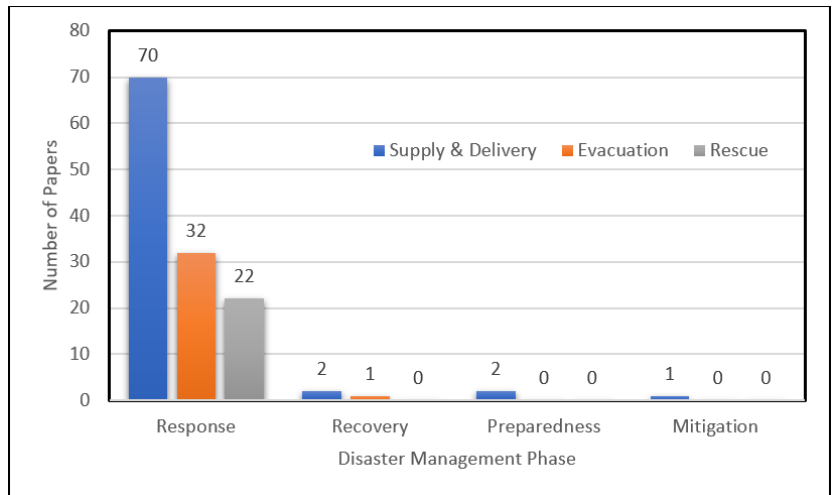
Figure 6. Selected Humanitarian Operation based on DM Phase.